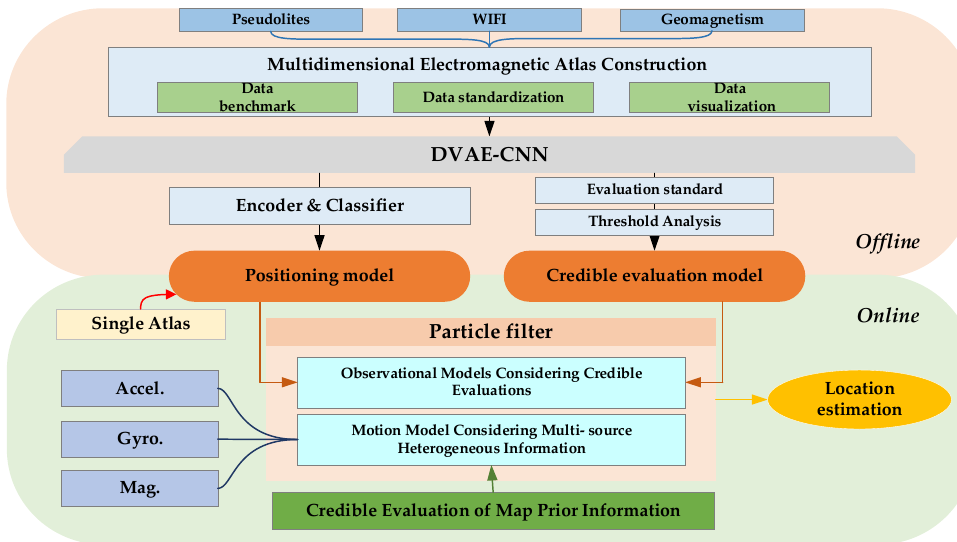
Figure 4. Structure of indoor positioning system considering credible evaluation.